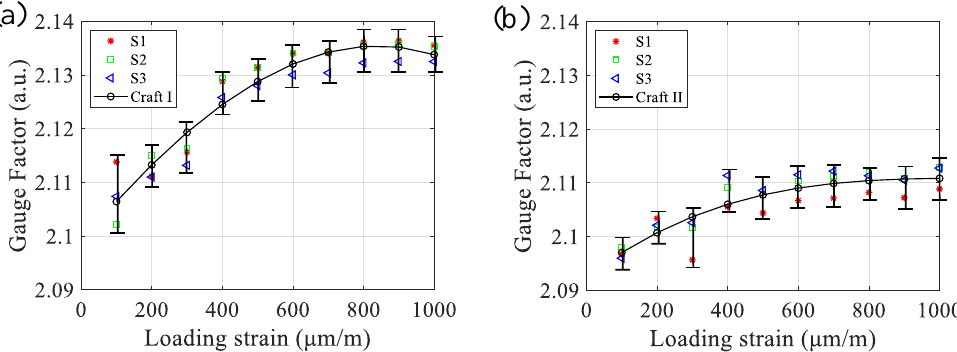
Figure 10. The GF was measured from two groups of fabricated strain gauges. Three samples with smoother sidewall profiles manufactured by Craft I ( a ), while the other three fabricated by Craft II have rougher sidewall profiles ( b ). The loading strain increases from 100 to 1000 μm/m.